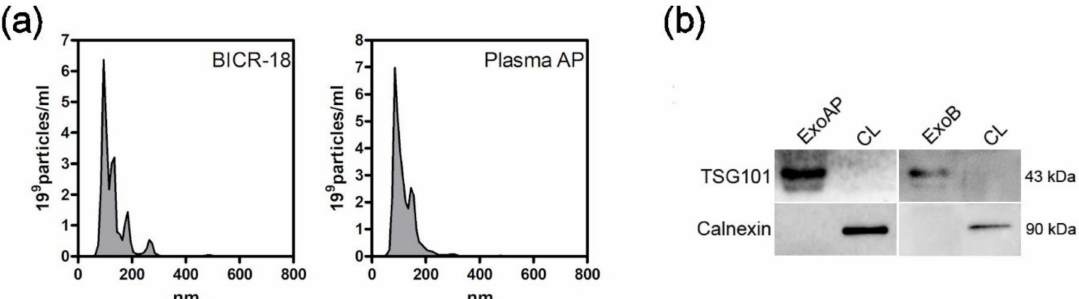
Figure 1. Characterization of extracellular vesicles: ( a ) Size distribution curves, evaluated by NanoSight, indicated that sizes are compatible with exosomes. ( b ) Western blot analysis was performed with whole cell lysates (CL) and pooled exosomes isolated from plasmatic acute pancreatitis-induced rats (ExoAP) and from epithelial cell line BICR-18 (ExoB) to confirm the presence of classical exosome marker (TSG101) and the absence of endoplasmic reticulum contamination (calnexin). ExoAP, exosomes from the plasma of acute pancreatitis-induced rats; CL, cell lysates; and ExoB, exosomes from